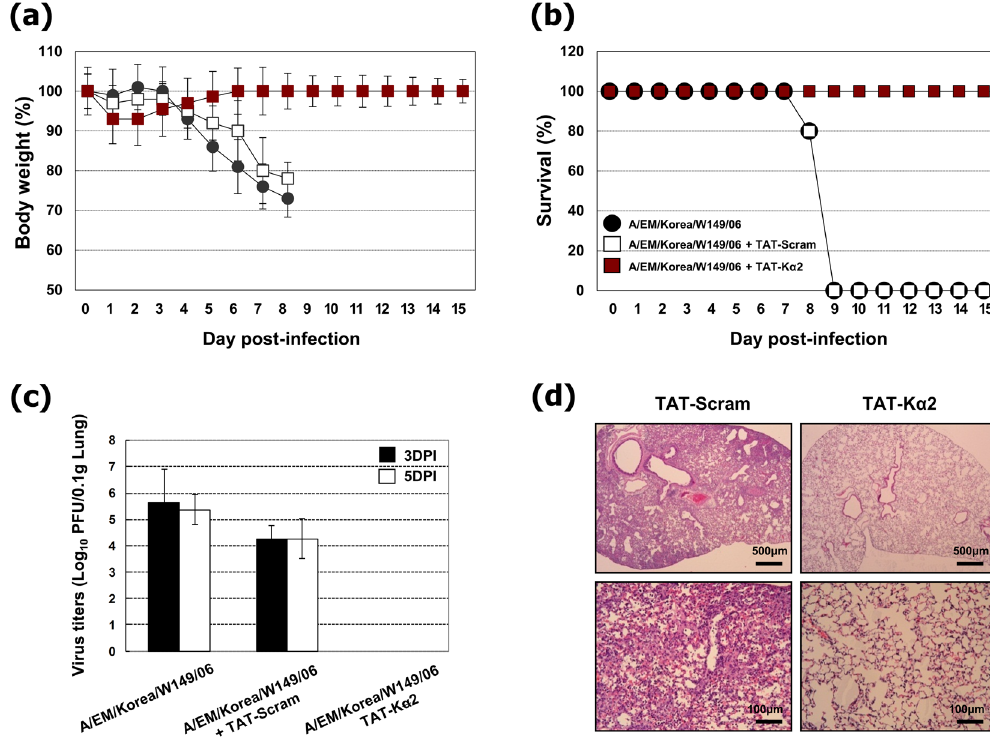
Figure 3. In vivo virucidal effect of the TAT-K α 2 peptide against HPAI (H5N1). The mice were inoculated with the W149 virus alone or mixtures of the W149 virus and each peptide (TAT-K α 2 or TAT-scramble peptides), and ( a ) percent body weight and ( b ) survival percentage were monitored for 15 days. ( c ) The lung virus titers of each group (three randomly selected mice from each group were sacrificed) are expressed as the means ± SD of the log 10 plaque-forming units (PFU) per 0.1 g of tissue. The closed bar indicates the virus titer at 3 DPI, and the open bar indicates the virus titer at 5 DPI. ( d ) Histopathologic observation at 5 DPI. The upper panels were observed by light microscopy at 40 × magnification, and the lower panels were observed at 200 ×